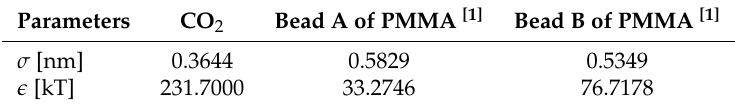
Table 1. Parameters for the species studied in this work.